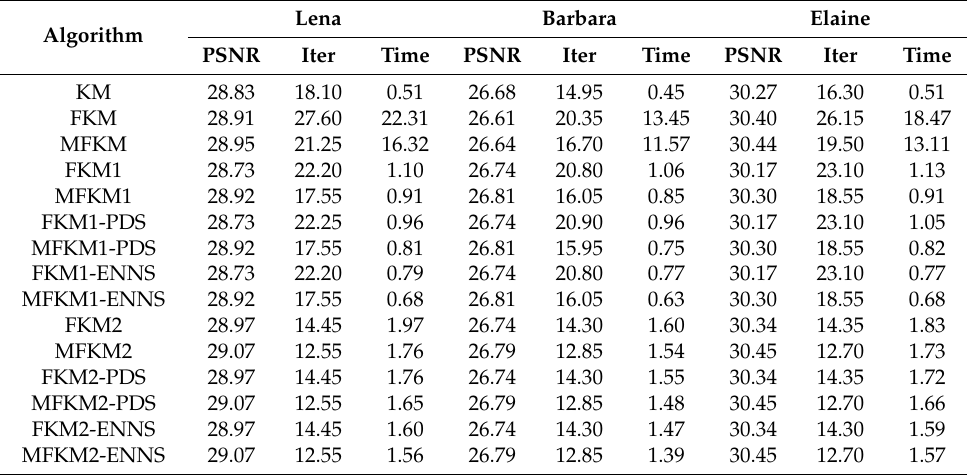
Table 6. PSNR (in dB), number of iterations and codebook design time (in seconds) for images Lena, Barbara and Elaine, using N = 128.